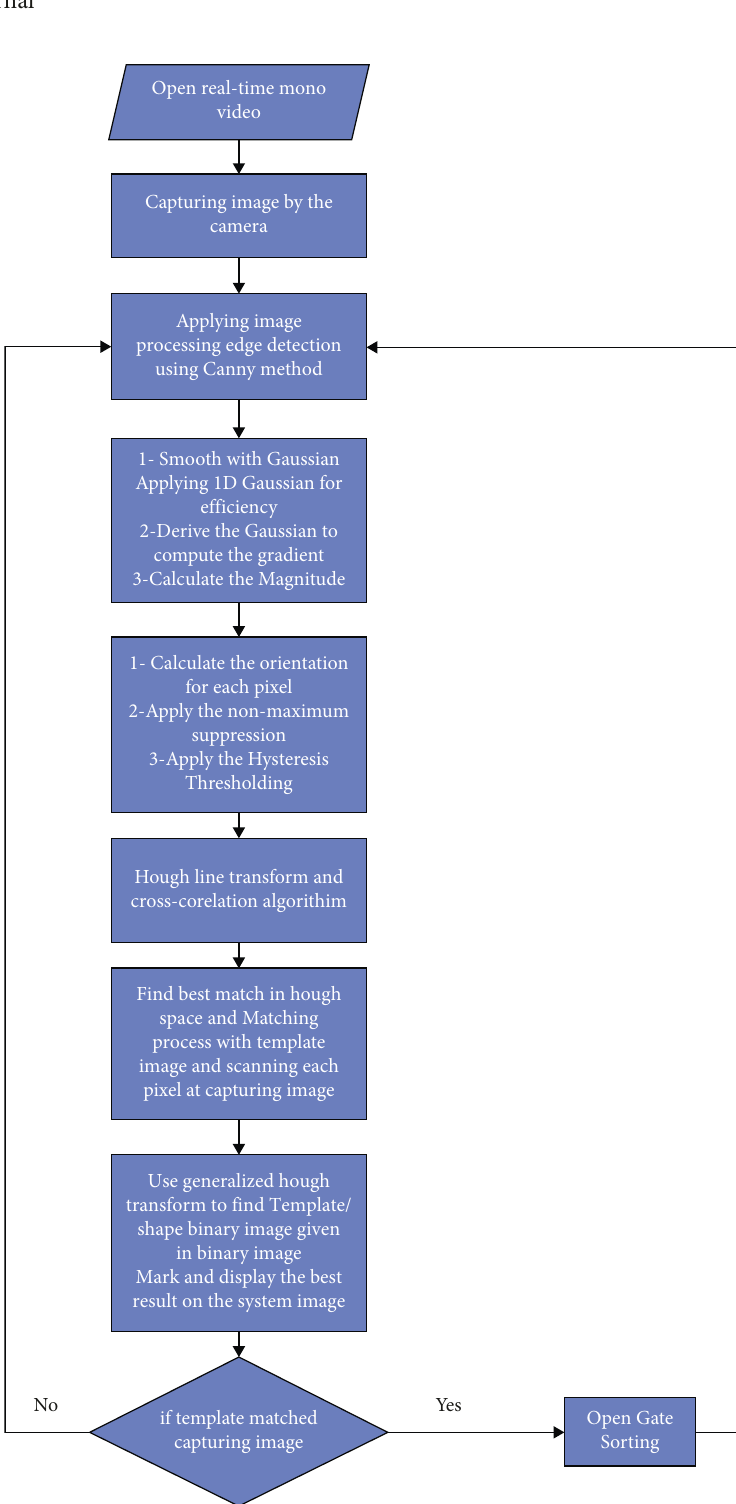
Figure 4: Flowchart showed the step of the system